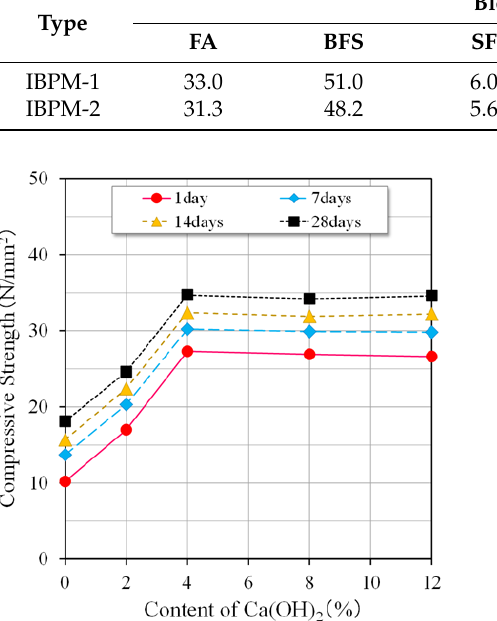
Figure 2. Particle size distribution of aggregates. Table 4. Blend ratio of IBPMs.